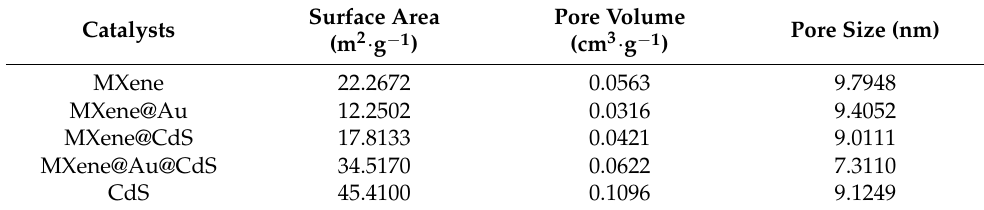
Table 1. The BET data of prepared samples [67].